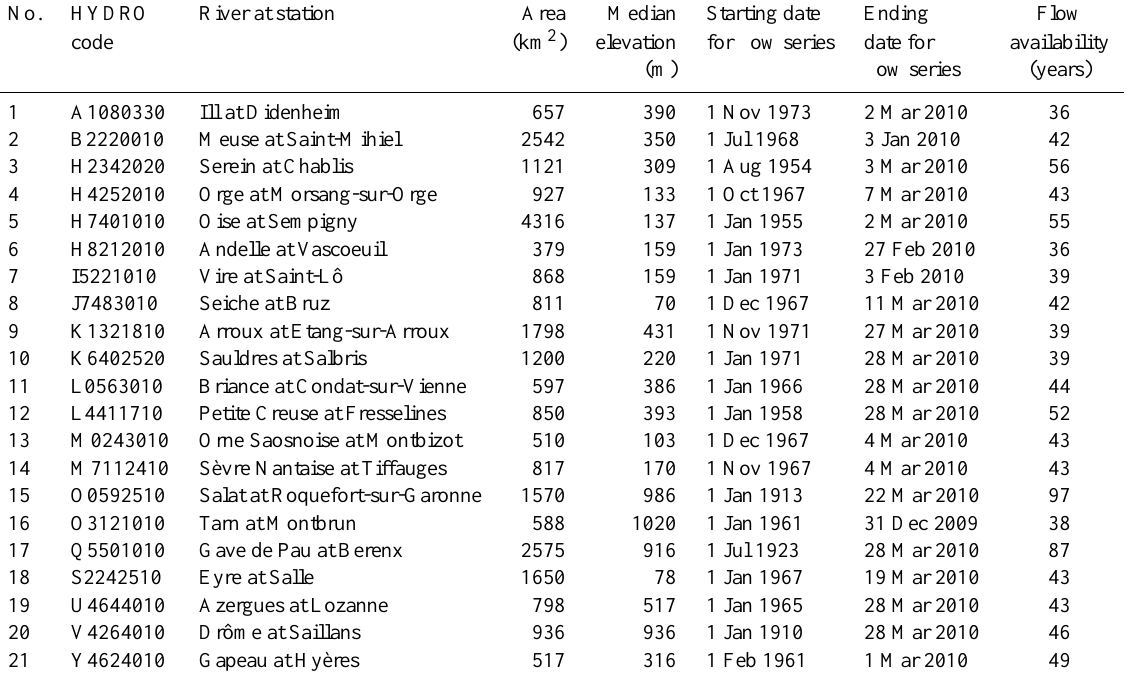
Table 1. Summary of the main characteristics of the 21 selected catchments.